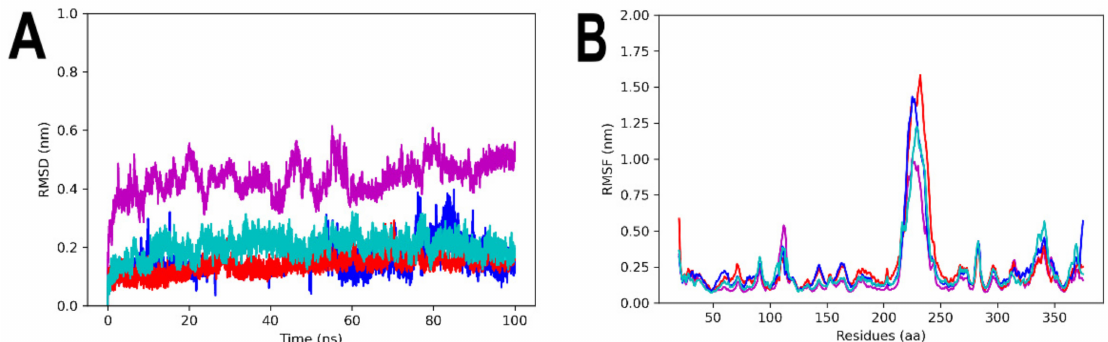
Figure 6. MDS analyses of apo-3ZKBL and 3ZKBL complexed with ANP, BS1, and ATD. ( A ) RMSD values. ( B ) RMSF values. The colors magenta, red, dark blue and light blue represent apo-3ZKBL, 3ZKBL-ANP, 3ZKBL-BS-1 and 3ZKBL-ATD respectively. The analyses were performed with